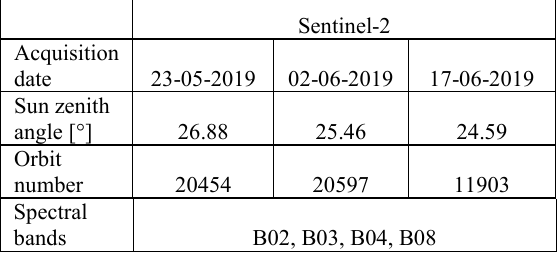
Table 2. Characteristics of the S2 imagery used in this